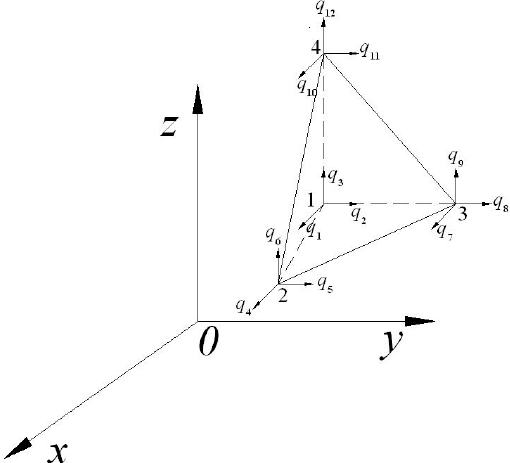
Figure 1. Four node tetrahedral element and its coordinate system.